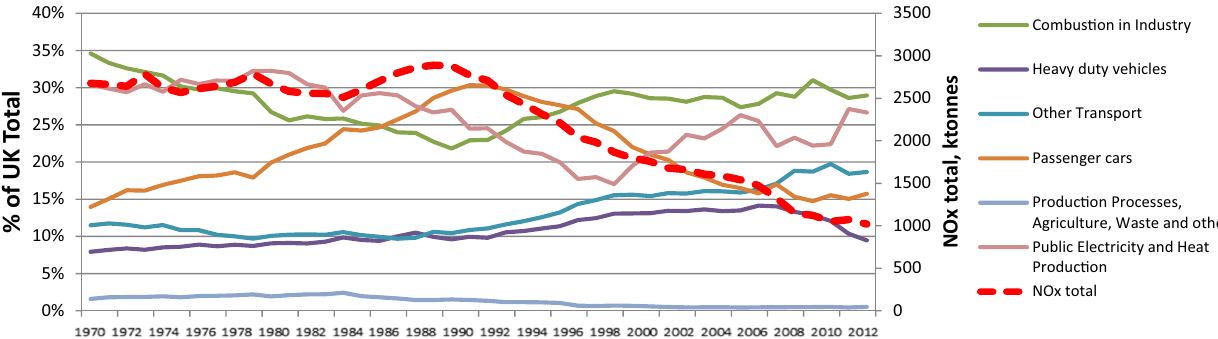
Fig. 1 NOx emissions by sector, UK, 1970 – 2013. Six sectors in percent, left-hand Yaxis. NOx total in kilotonnes, right-hand Yaxis. Sector definitions are not exactly the same as those in the subsequent table, so figures are somewhat different, but still representative. (Source: NAEI)